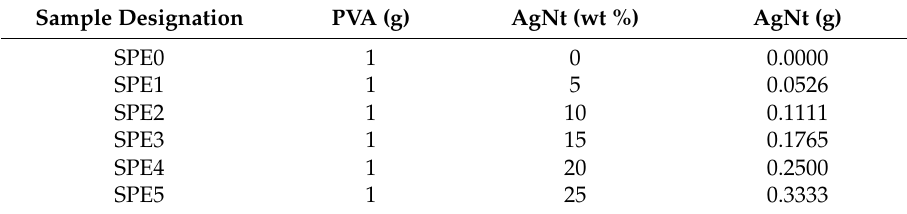
Table 1. The composition of PVA:AgNt based solid polymer